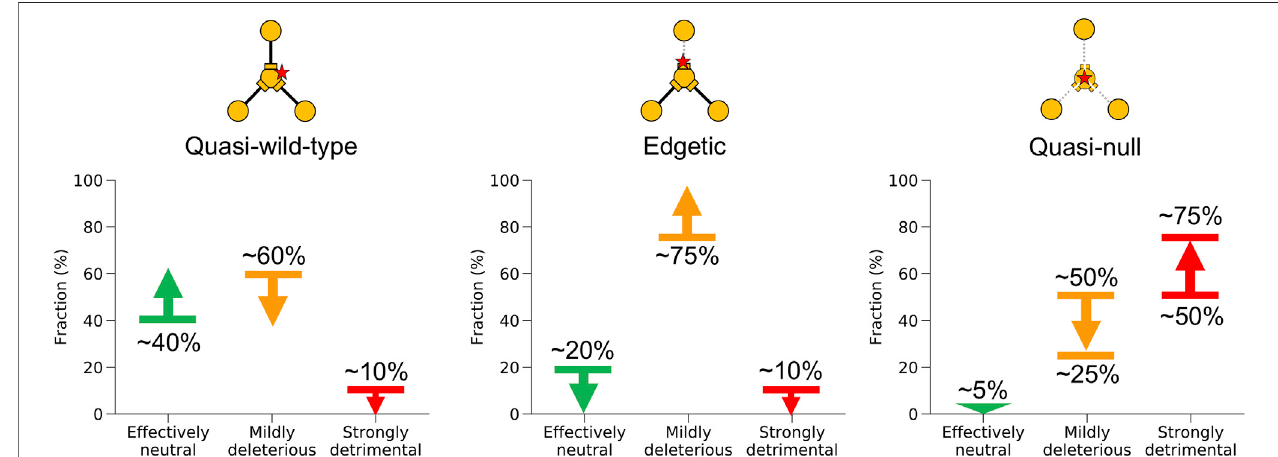
FIGURE 7 | Summary of fi tness effect for different mutation edgotypes in human. Probabilities for quasi-wild-type mutations, edgetic mutations, and quasi-null mutations to be effectively neutral, mildly deleterious, or strongly detrimental in human. Probabilities were obtained by merging the results from mutation fi tness effect calculations under both assumptions (I) that strongly detrimental mutations are quasi-null rather than edgetic or quasi-wild-type, and (II) that strongly detrimental mutations are as likely as mildly deleterious mutations to be quasi-null, edgetic or quasi-wild-type.